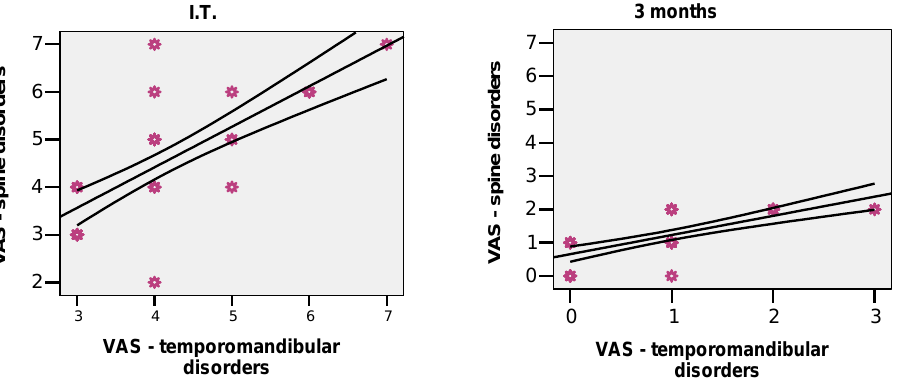
Figure 3. Correlation between VAS values in experimental group with temporomandibular and spine disorders (I.T. – initial vs. 3 months).